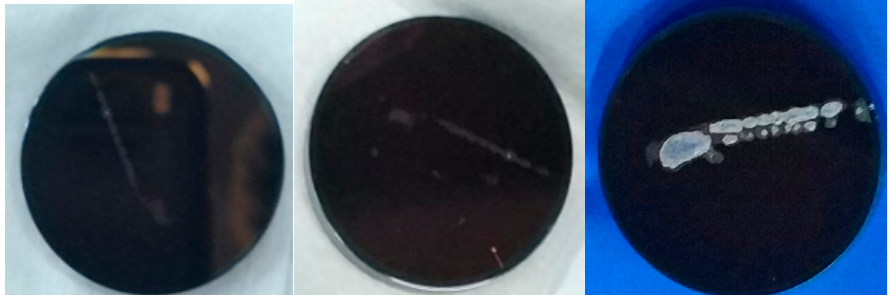
Figure 9. Damage phenomenon of the Ge window by the composite laser. Table 9. Damage phenomenon of the Si window by the composite laser.